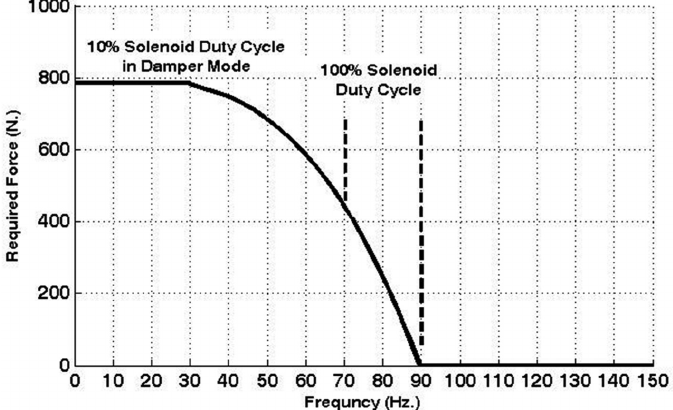
Fig. 6. Required force versus notch